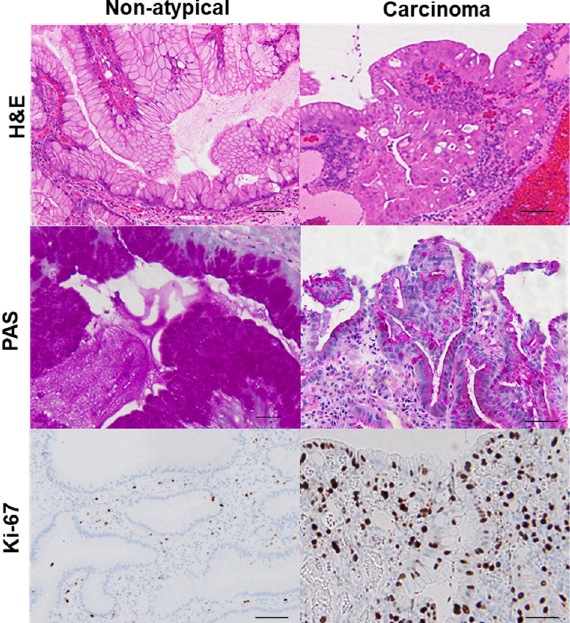
Figure 2. Comparison of mucus production and proliferative activity between a hyperplastic polyp and its carcinoma lesion.In the same hyperplastic polyp (case 2 in Table 3), non-atypical regions and the carcinoma lesion were compared. In the non-atypical region, PAS-positive mucus is abundant in most foveolar epithelial cells, whereas in the cancer lesion, PAS-positive mucus is only found in a few cells. Ki-67-positive cells were scattered in non-atypical regions with an index of 5%. By contrast, in the cancer lesion, a high number of Ki-67-positive cells were evident, up to the surface layer of the glands (index of 92%). H&E, hematoxylin and eosin; PAS, periodic